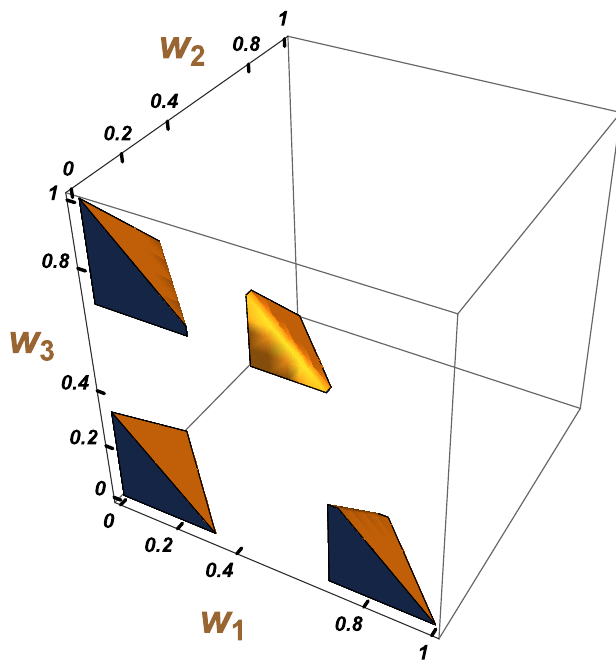
Figure 6: Shaded part of parameter space of Bell diagonal family (25) gives states useful in CJWR-based QKD protocol but useless in CHSH-based protocol.